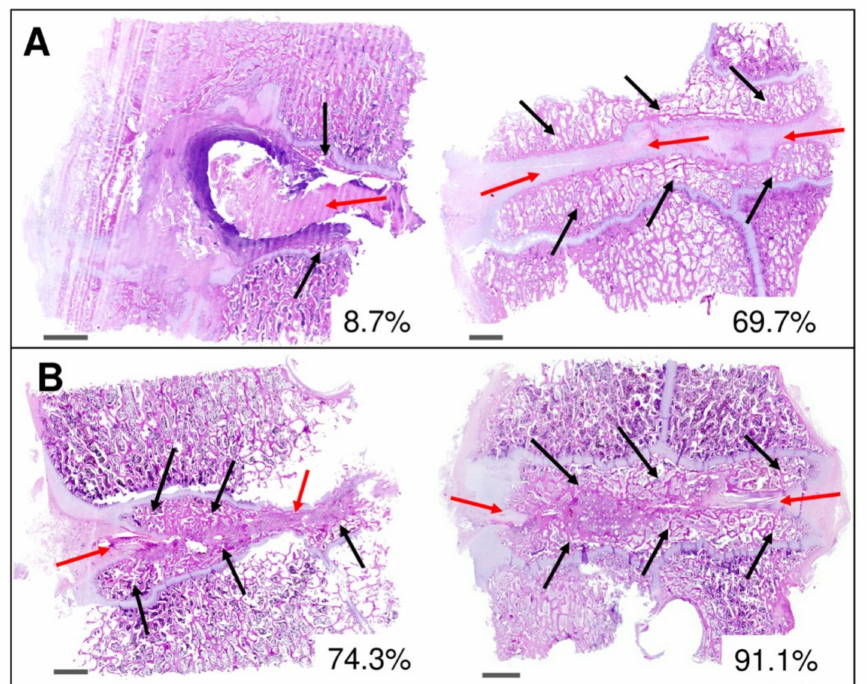
Figure 11. Histomorphological analysis of the intervertebral fusion area after 16 weeks in subgroup A2 (bone autograft) ( A ) and B2 (bioresorbable hybrid implant) ( B ). Red arrows depict fibrocartilage tissue in the area of the implementation site. Marked areas with black arrows represent newly formed trabecular bone tissue having visible bone marrow with trilineage hematopoiesis in the new bone formation. Selected images show low and high amount of bone fusion in %. Scalebar of 2 mm in each